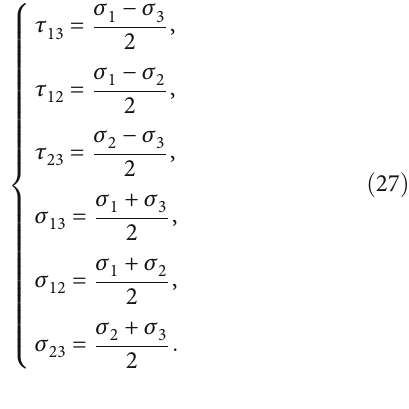
Figure 6: Location of the high loess slope and terrain of Jingyang loess